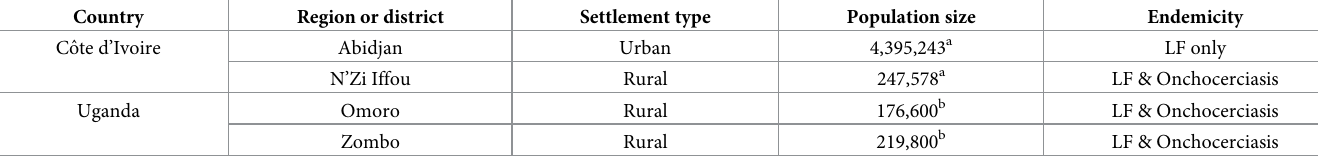
Table 1. Description of study